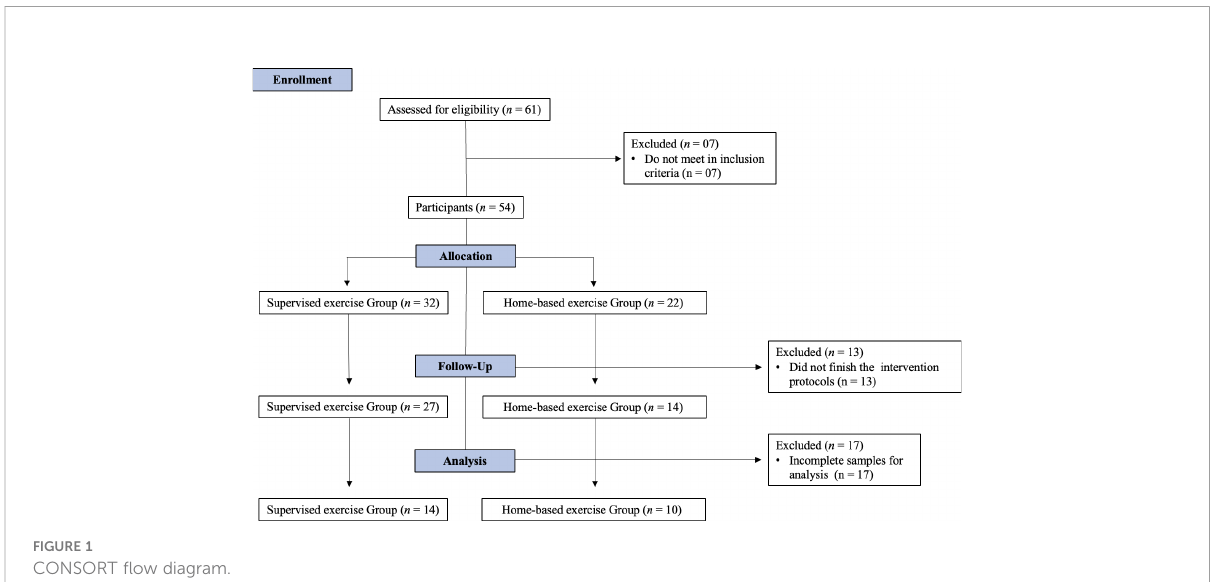
FIGURE 1 CONSORT fl ow